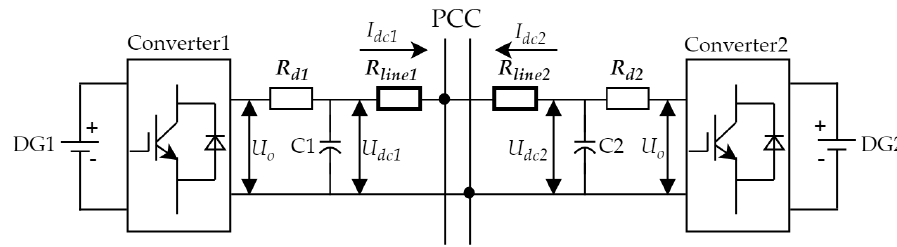
Figure 3. DC converter parallel system structure diagram. PCC: Point of common coupling.